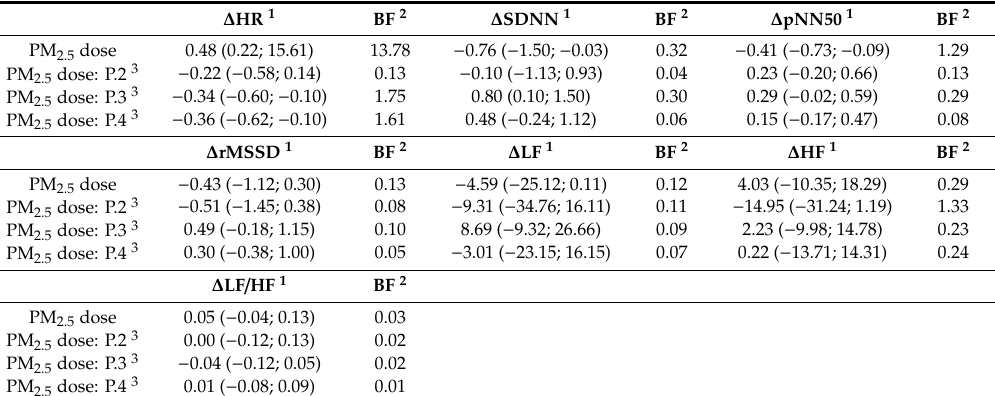
Table 5. E ff ects of total inhaled doses of PM 2.5 on ECG parameters variability 1 . ∆ HR 1 BF 2 ∆ SDNN